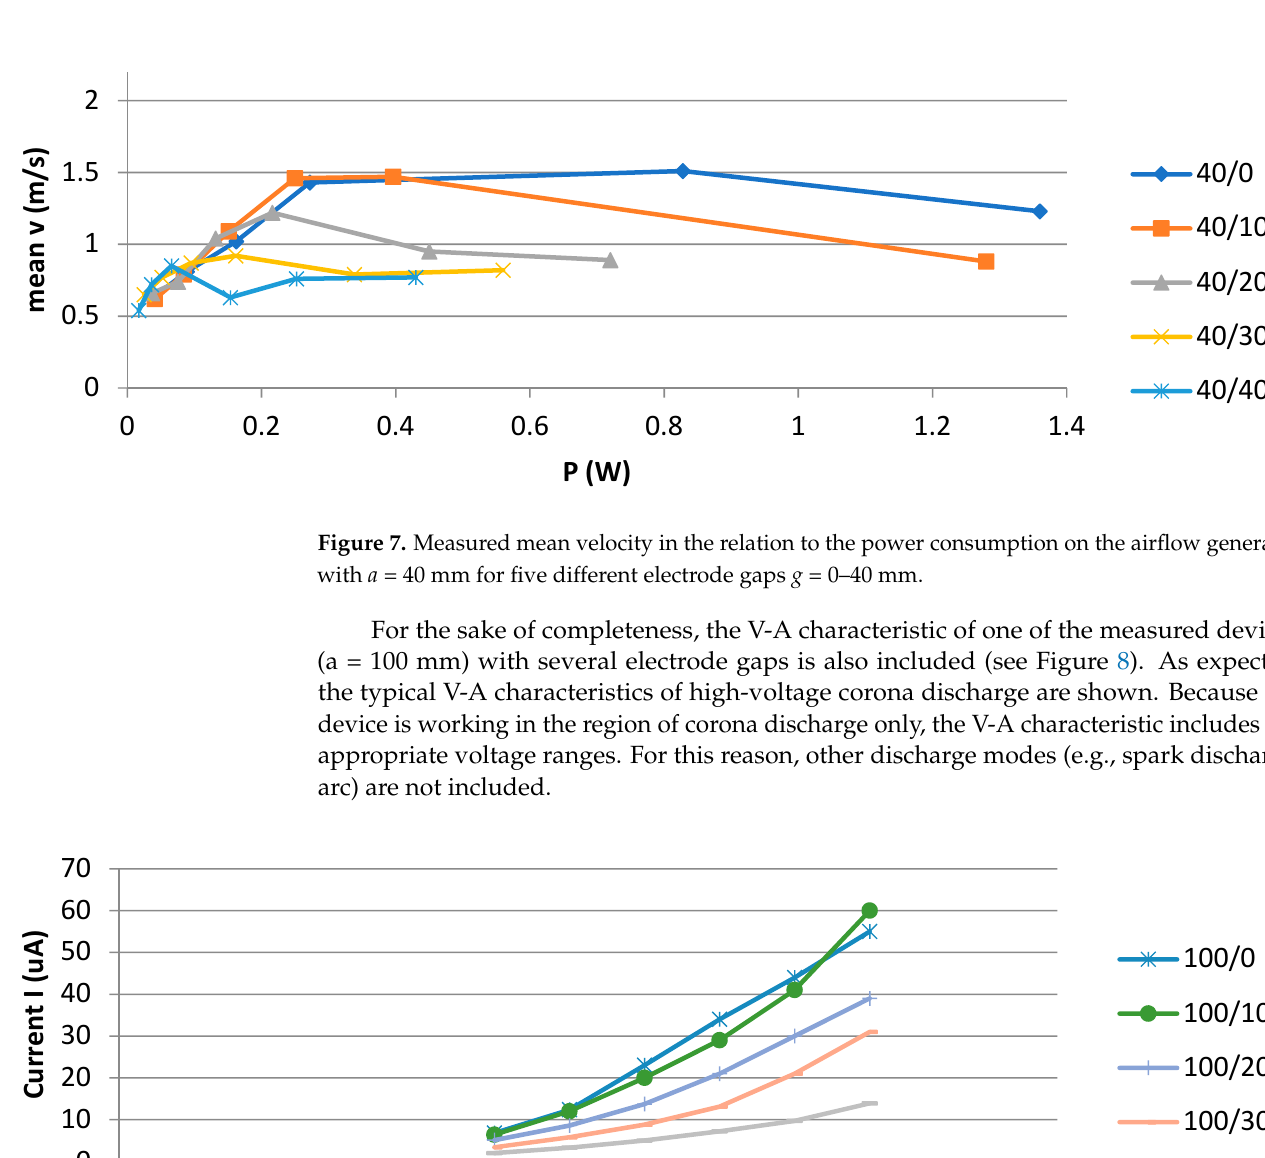
Figure 8. Measured V-A characteristic of the air fl ow generator with a = 100 mm for fi ve di ff erent electrode gaps g . To further examine the generated air fl ow, the authors used the particle image ve- locimetry (PIV) method [17], which can be successfully used even in these speci fi c con- ditions, where the strong electric fi eld is present [18]. The PIV method begins with seed-